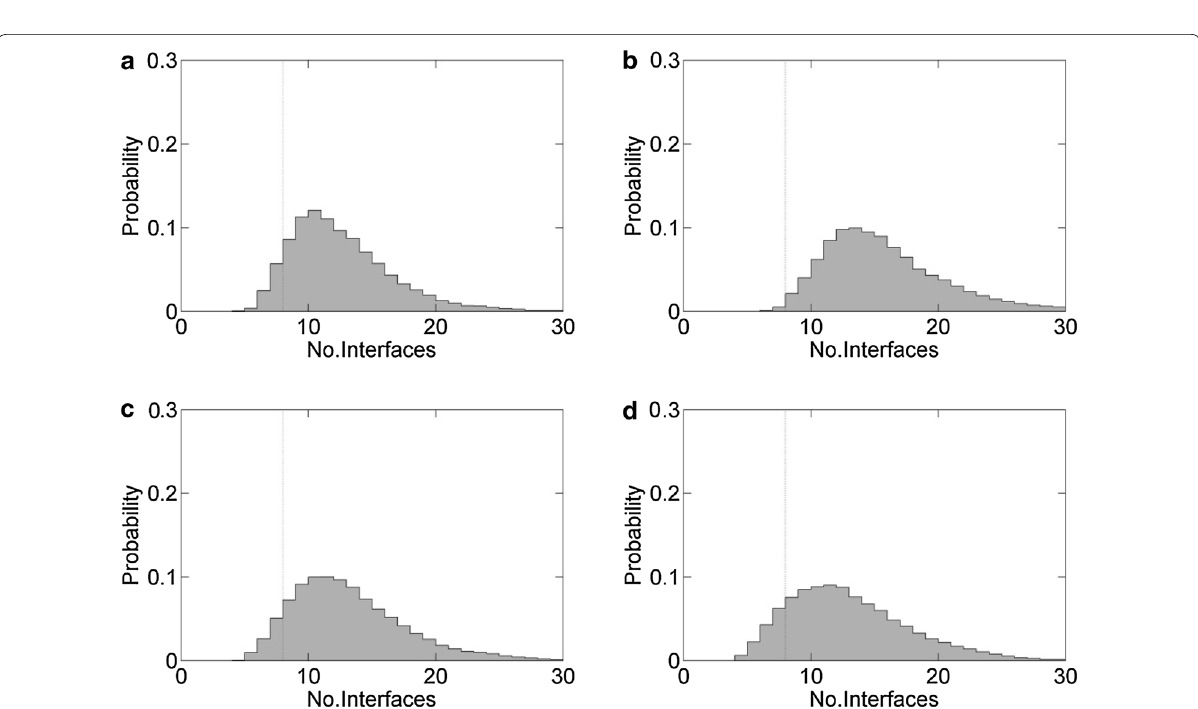
Fig. 4 1D marginal distributions of the number of interfaces k and the data misfit for the eight-layer model from the inversions ( a , c ) with and ( b , d ) without considering error correlations. The upper panels are for the AR(1) parameter a represent true